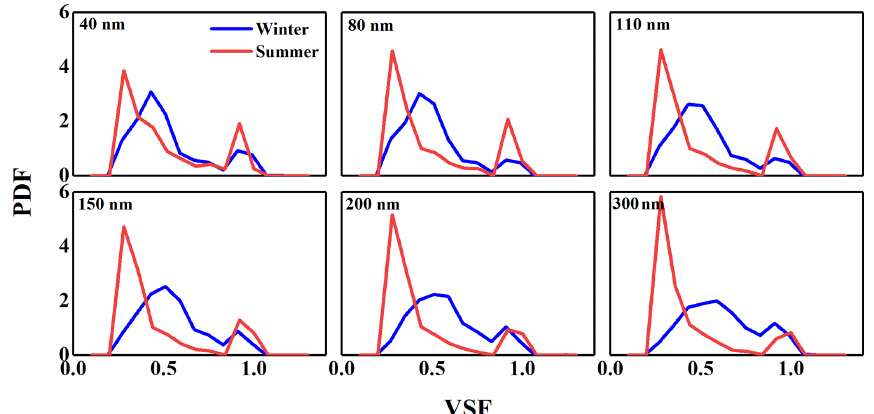
Figure 6. Average volatility shrink factor (VSF) distributions for different sizes (40–300nm) during the winter (in blue) and summer (in red)